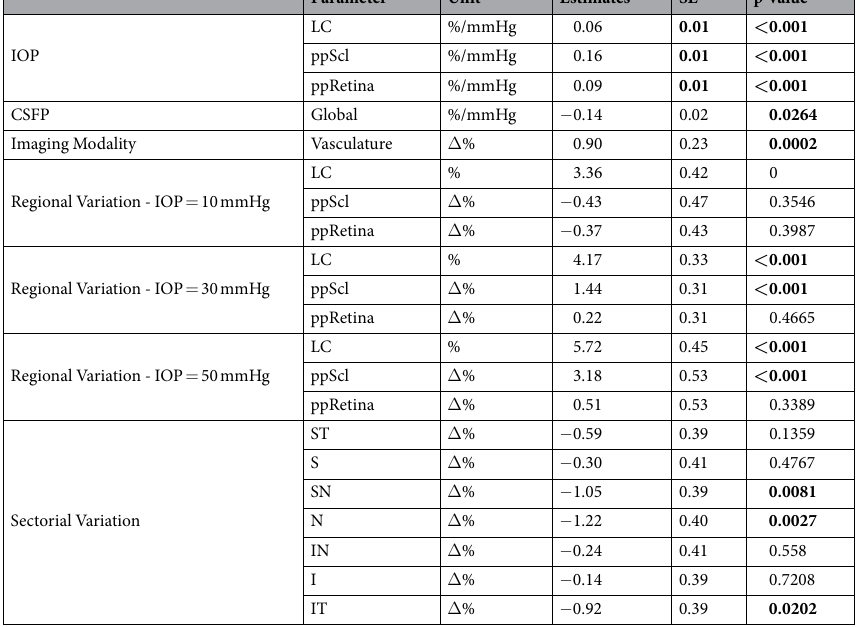
Table 1. Multi-variate Regression Model of the Regional and Sectorial Strain Variation with IOP, CSFP, and Imaging Modality. The inferior sector was set as the intercept. ppScl = peripapillary sclera; ppRetina = peripapillary retina; IOP = intraocular pressure; CSFP = cerebrospinal fluid